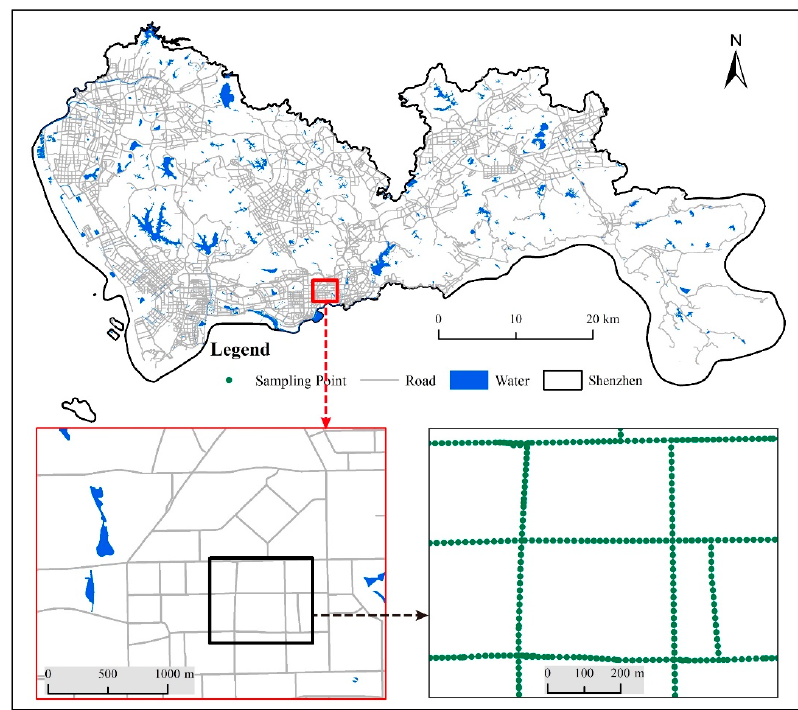
Figure 3. Sampling points collected across the road network of